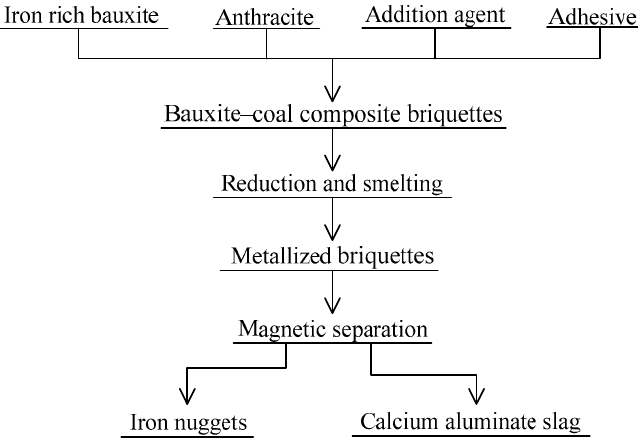
Figure 3. The experimental procedure of the semi-smelting reduction and magnetic separation process.